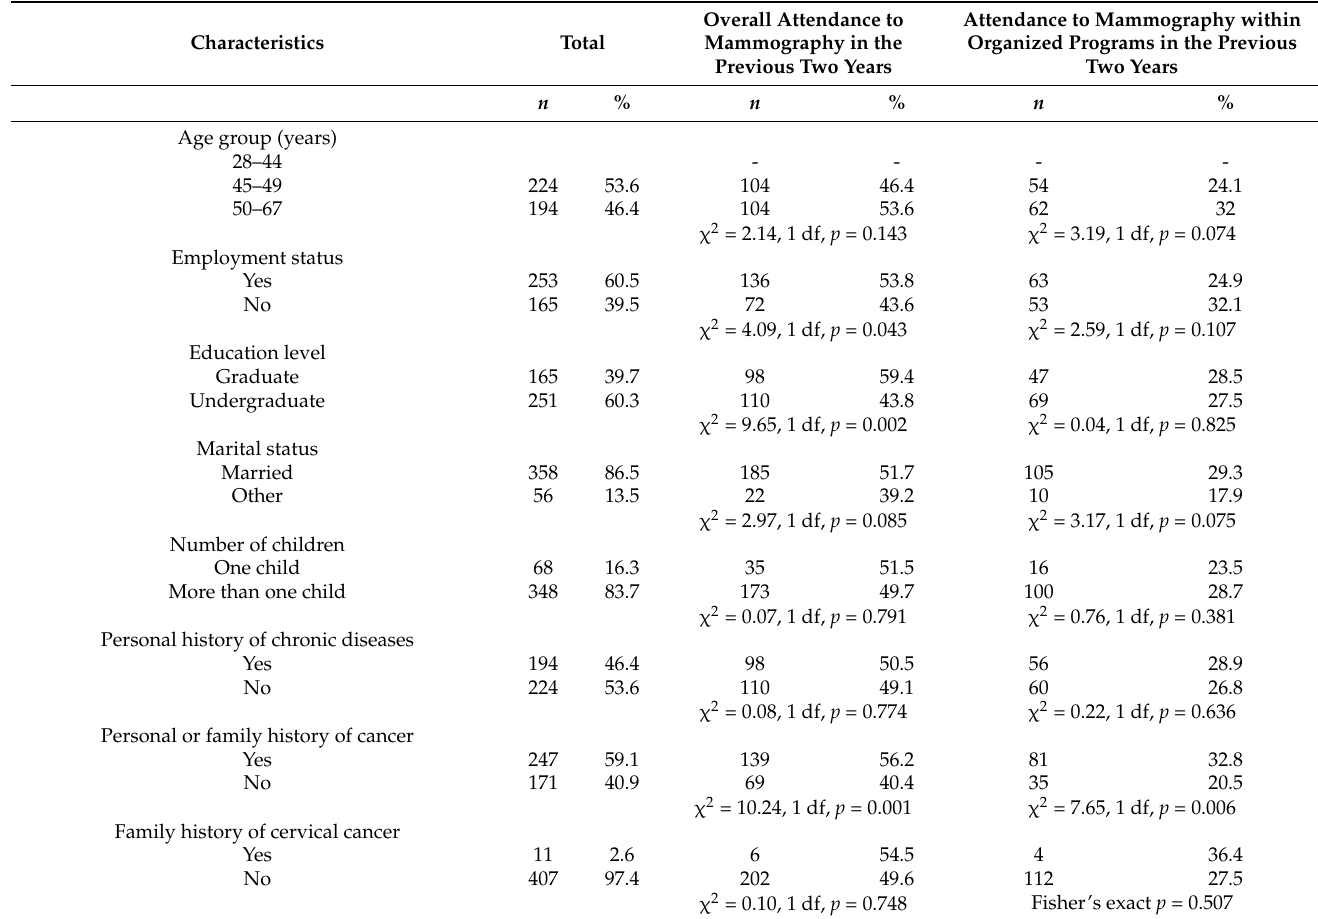
Table 3. Respondents’ socio-demographic, anamnestic and lifestyle characteristics and related attendance to mammography in the previous two years overall and within organized screening programs ( n =